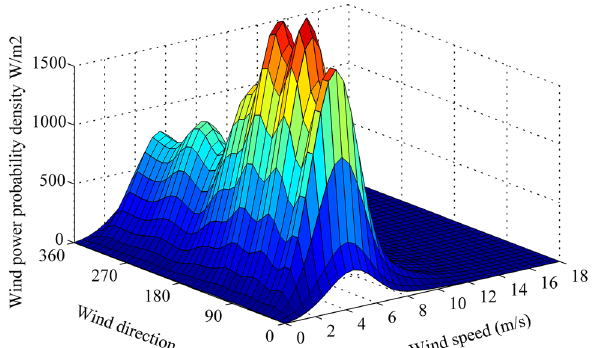
Figure 6. Wind power probability density. Figure created using Matlab R2014a (https:// www. mathw orks. com).